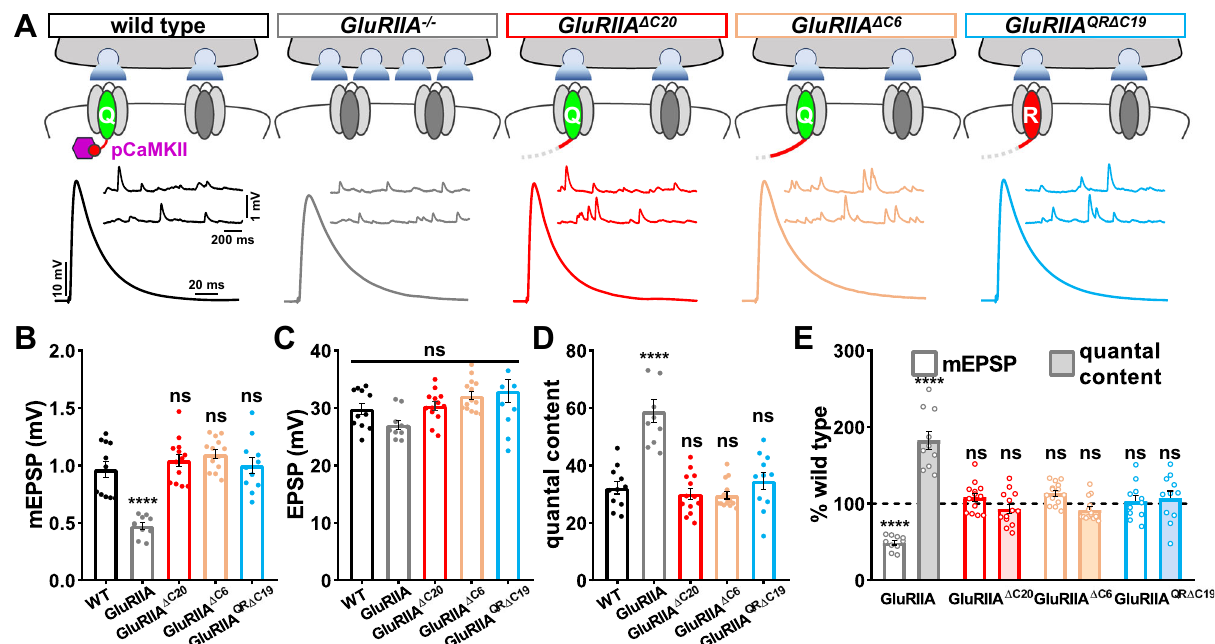
Fig. 6 | Loss of active pCaMKII does not trigger retrograde homeostatic sig- naling.A Schematics and representativetraces show thatloss ofthe GluRIIA C-tail does not alter spontaneous neurotransmission or presynaptic function. B – D Quanti fi cation of average mEPSP amplitude ( B ), EPSP amplitude ( C ), and quantal content ( D ) values in the indicated genotypes shown in ( A ). E Quanti fi cation of mEPSP and quantal content values of the indicated genotypes normalized to wild-type values (wild type: n =11; GluRIIA − / − , n =10, p <0.0001 for mEPSP, p =0.276 for EPSP, p <0.0001 for QC; GluRIIA Δ C20 : n =13, p =0.682 for